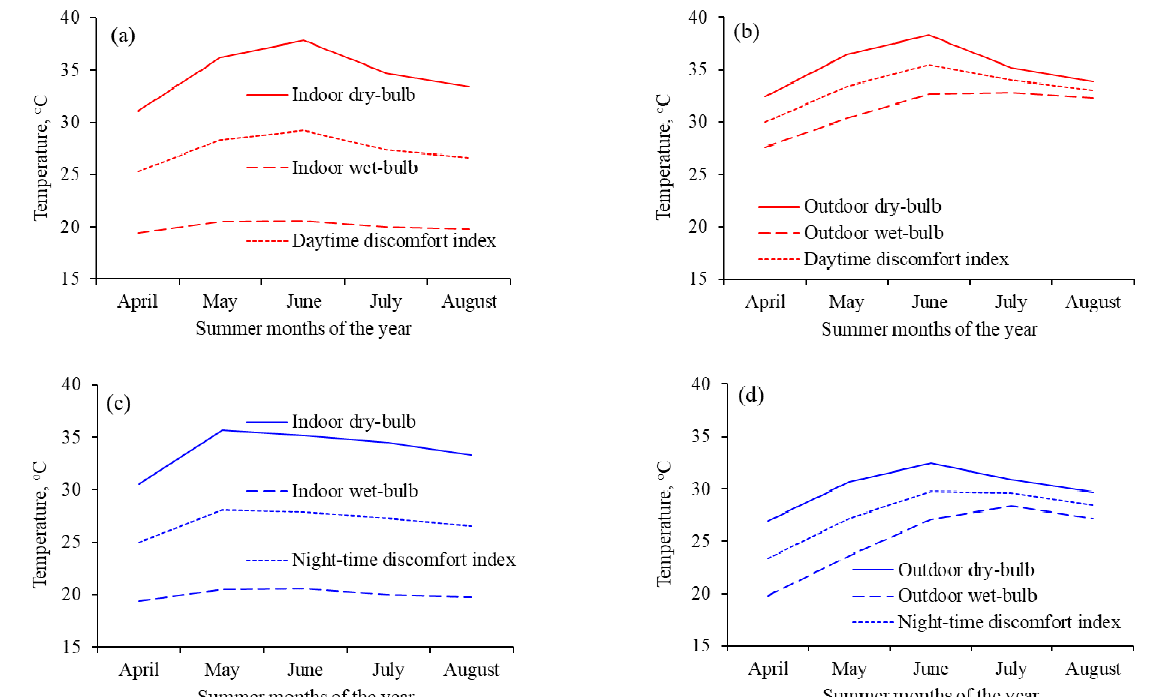
Figure 6. Variations in the monthly averaged discomfort indices caused by increasing and/or decreasing dry- and wet-bulb temperatures of the indoor day, night ( a , c ), and outdoor day, night ( b , d ) conditions during the five months of summer 2016.